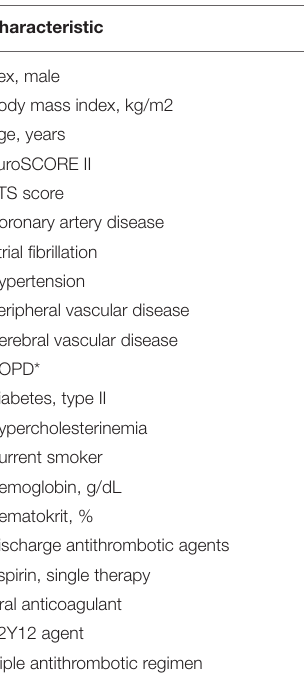
TABLE 1 | Baseline clinical characteristics according to used closure